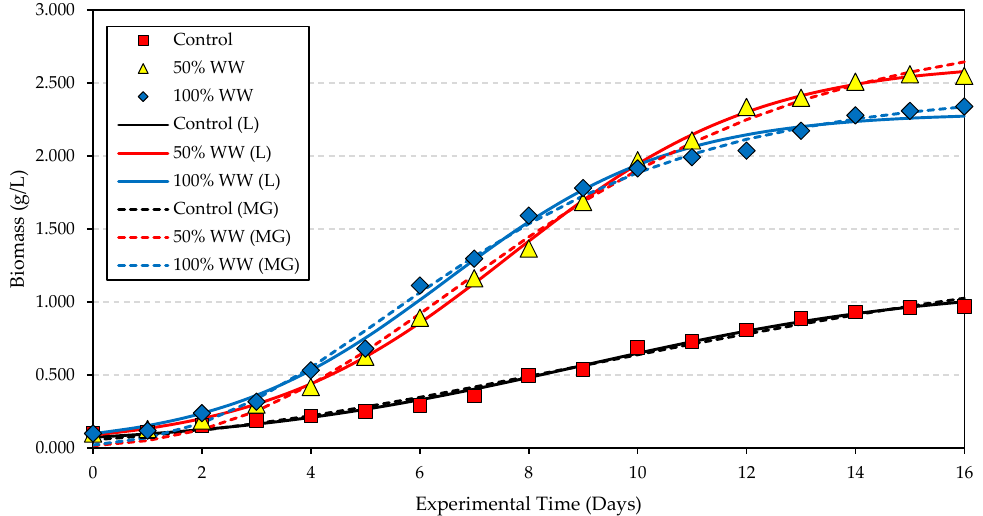
Figure 4. Experimental vs. model predicted (L: logistic; MG: modified Gompertz; WW: wastewater) growth curves of C. vulgaris cultivated in different concentrations of mushroom farm wastewater.